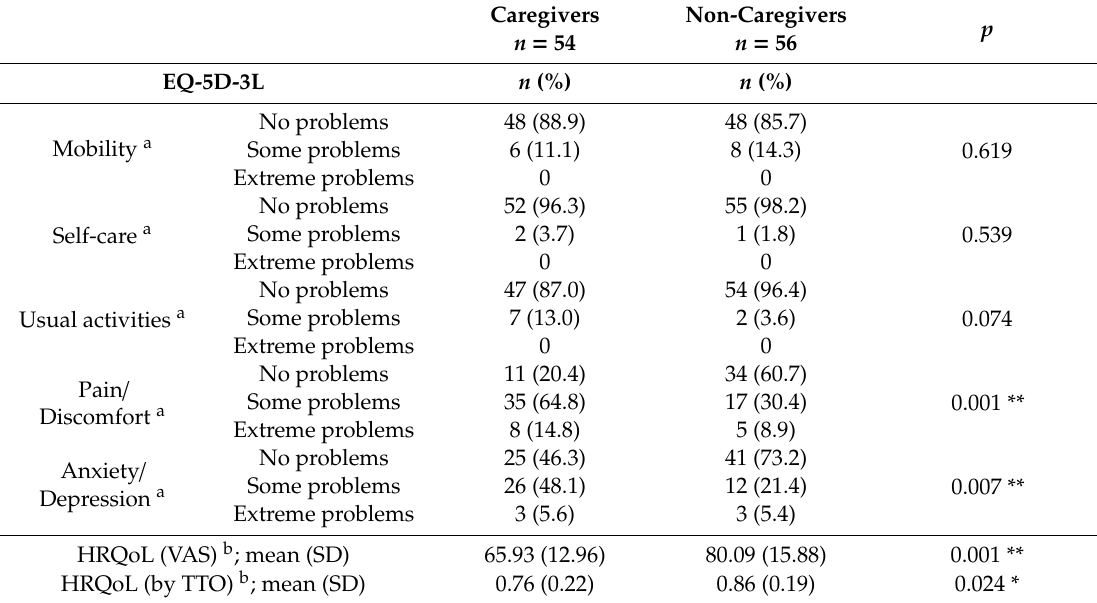
Table 3. Comparison of health-related quality of life (from EuroQol-Five Dimensions-Three Levels (EQ-5D-3L)) between participants.